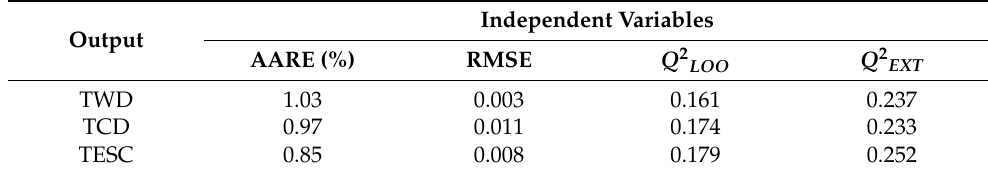
Table 9. Results of SVR modeling for mushroom